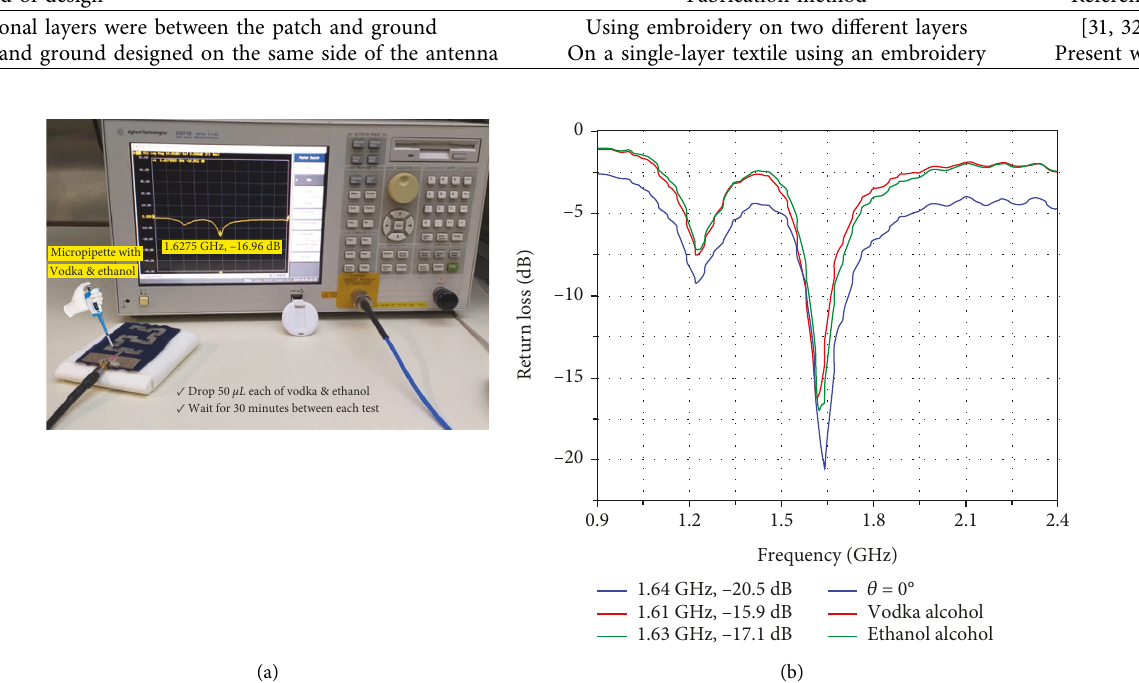
Table 2: Summary of the novelty of the present work compared with previous works. Method of